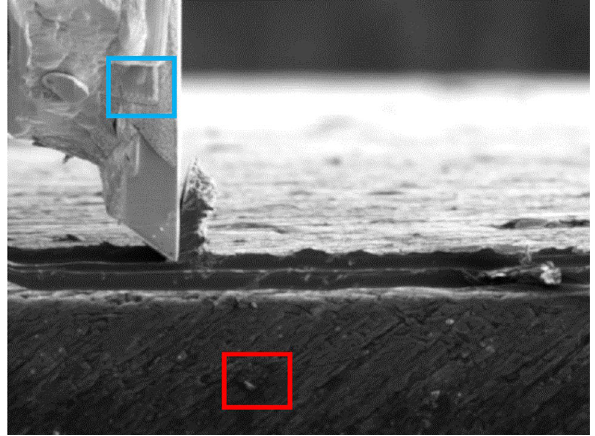
Figure 12. ROIs subject of tracking on the tool (blue) and the workpiece (red) for computing cutting force and displacement.